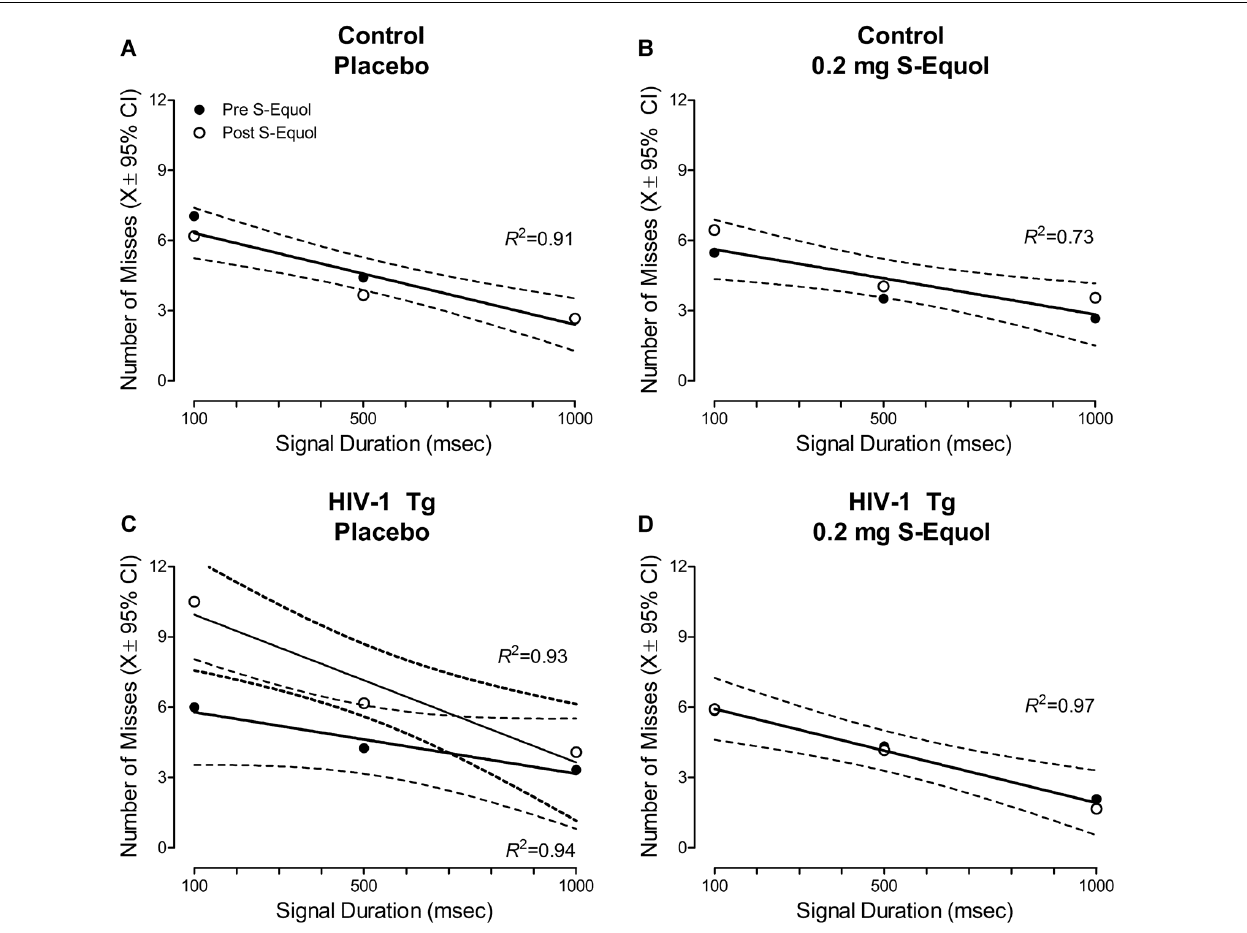
FIGURE 6 | A pretest-posttest experimental design was utilized to examine the effect of S-Equol [SE; Placebo (A,C) or 0.2 mg (B,D) ] on the number of misses across time in control (A,B) and HIV-1 Tg (C,D) animals. Neither placebo nor 0.2 mg SE treatment altered the number of misses in control animals across time (A,B) , evidenced by a global first-order polynomial fit. HIV-1 Tg animals treated with placebo displayed an increase in the number of misses at the post-SE assessment relative to the pre-SE assessment (C) , supporting neurocognitive decline across time; an effect that was prevented by treatment with 0.2 mg SE (D)